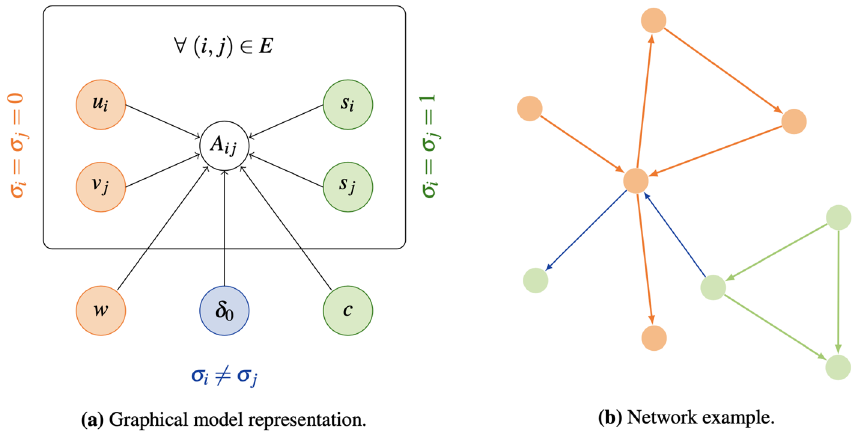
Figure 1. Model visualization. ( a ) Graphical model: the entry of the adjacency matrix A ij is determined by the community-related latent variables u , v , w (orange), by the ranking-related ones s , c (green) and by the out- group interaction parameter δ 0 (blue), depending on the values taken by the node type latent variables σ i , σ j . E denotes the set of network directed edges. ( b ) Example of possible realization of the model: orange nodes interact mainly via community, i.e. σ i = 0 , green ones via hierarchy, i.e. σ i = 1 . Orange and green edges are interactions between nodes of the same type (matching node color), while blue edges are interactions between nodes of different